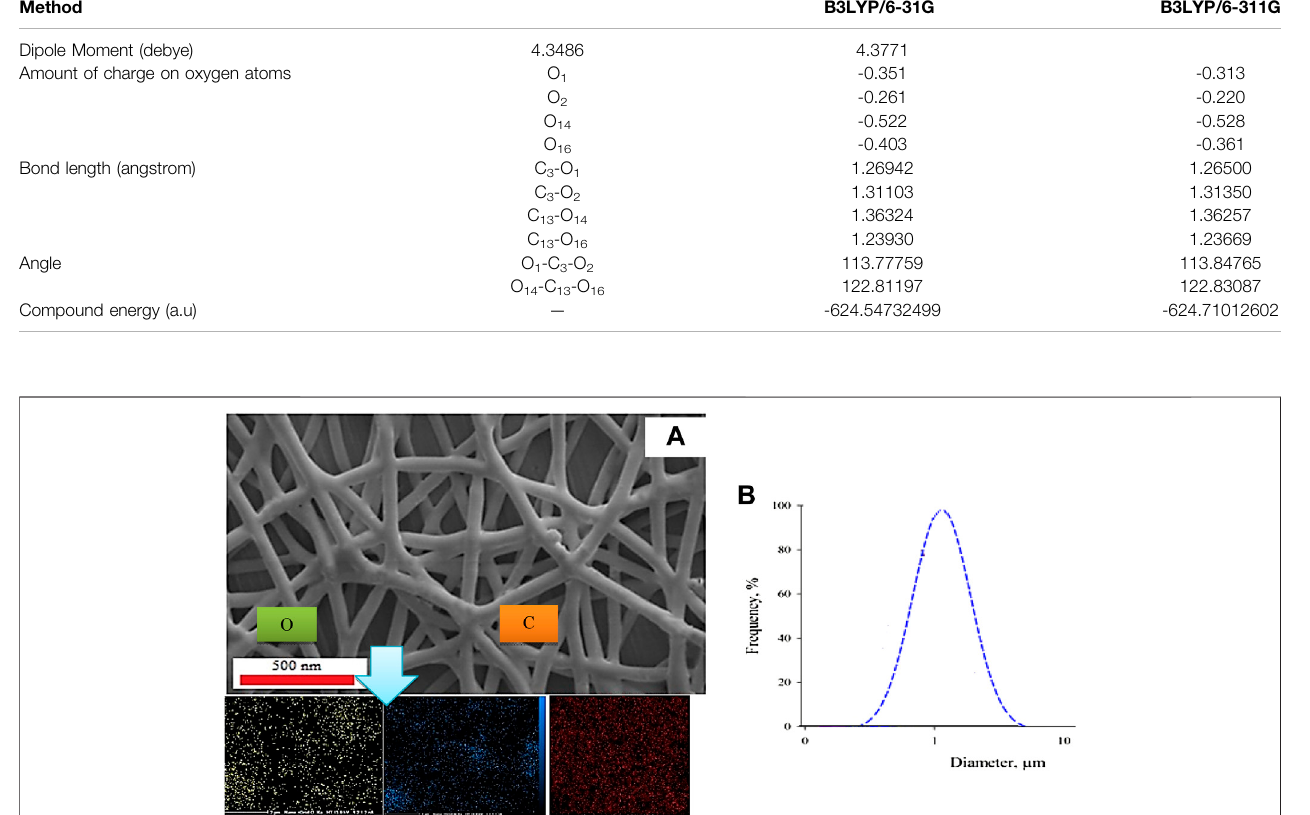
Frontiers in Materials |